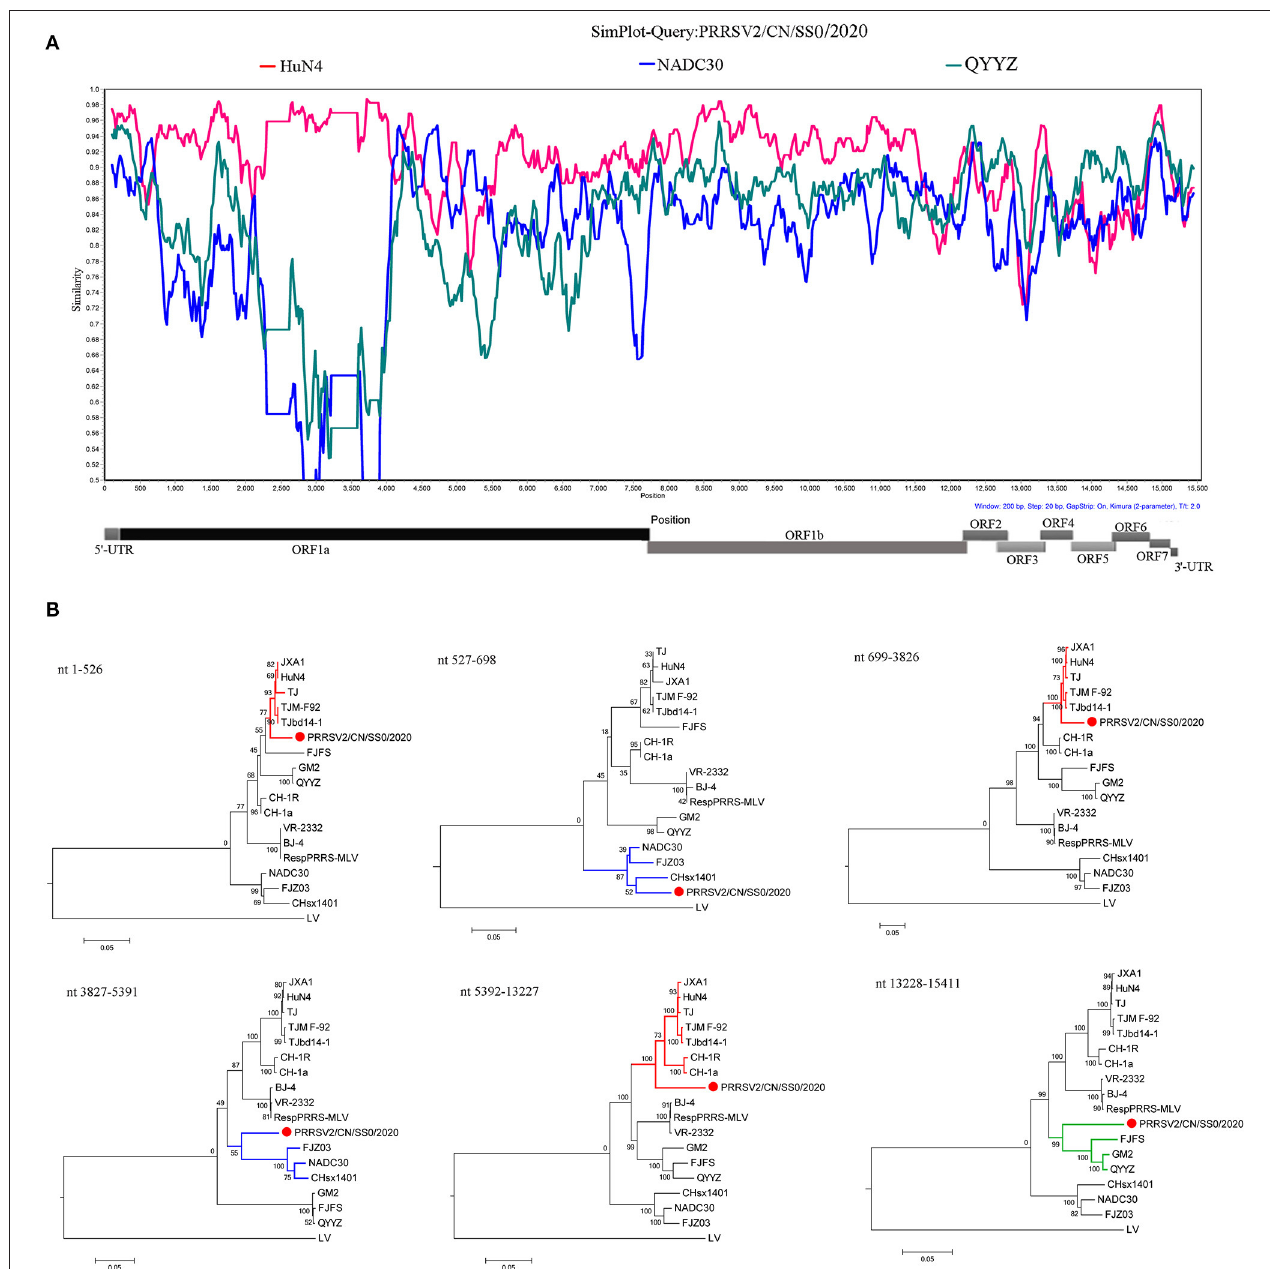
FIGURE 4 | Similarity plot analysis (A) and phylogenetic trees analysis based on different regions (B) of PRRSV2/CN/SS0/2020. For similarity plot analysis, the y-axis indicates the percentage identity between the parental sequences and the query sequence. The complete genome RRSV2/CN/SS0/2020 was chosen as the query sequence,